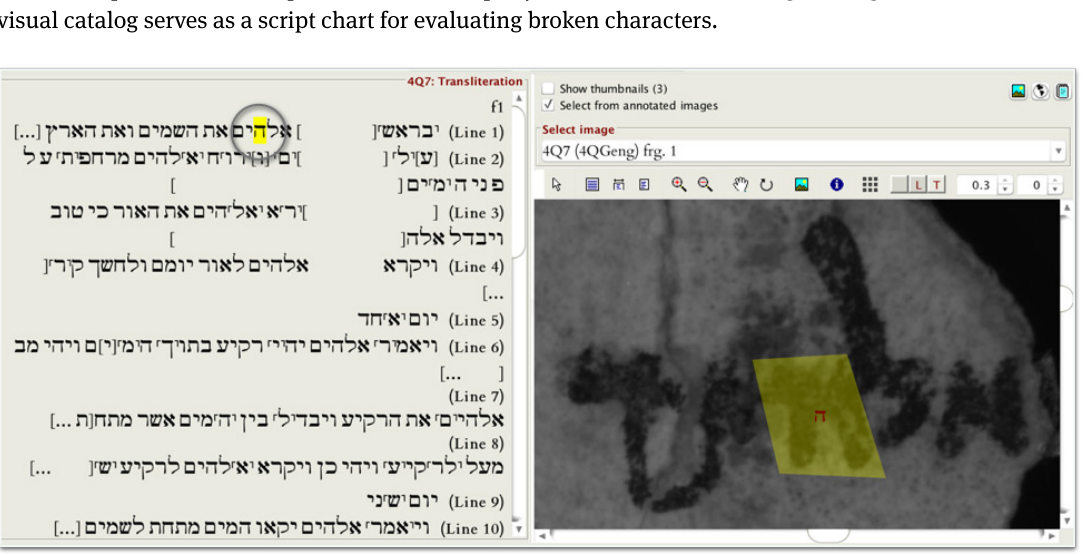
Figure 8: A transcription and image of a Dead Sea Scroll showing a “hot-spot” for the letter he ; image used by permission of the Israel Antiquities Authority.